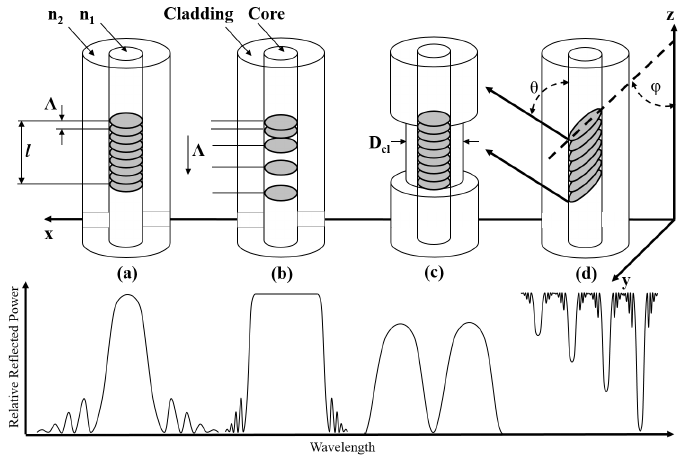
Figure 1. Different fiber gratings; ( a ) standard; ( b ) chirped; ( c ) micro-structured; and ( d ) tilted, with their corresponding reflection/transmission spectra below.